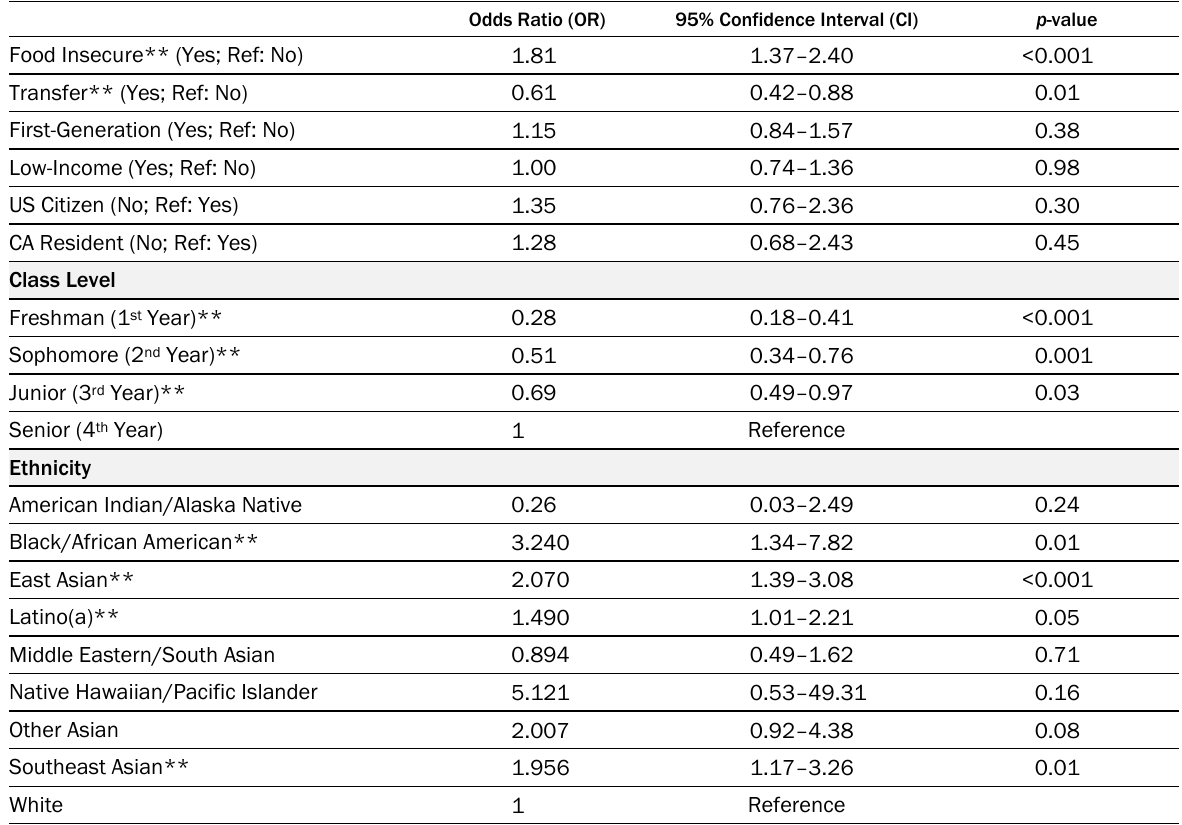
Table 4. Prediction of Food Resource Use by Logistic Regression Odds Ratio (OR) 95% Confidence Interval (CI) p